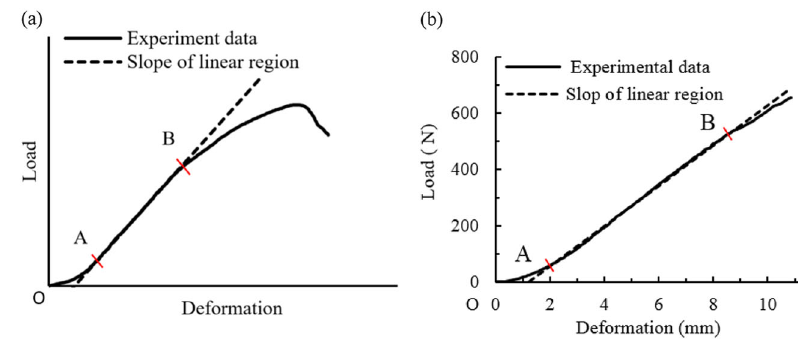
Fig. 1 Typical load-deformation curves for collagen fi ber-based tissues. a For a rabbit limb tendon [8]. b For the bone medial collateral ligament of dog